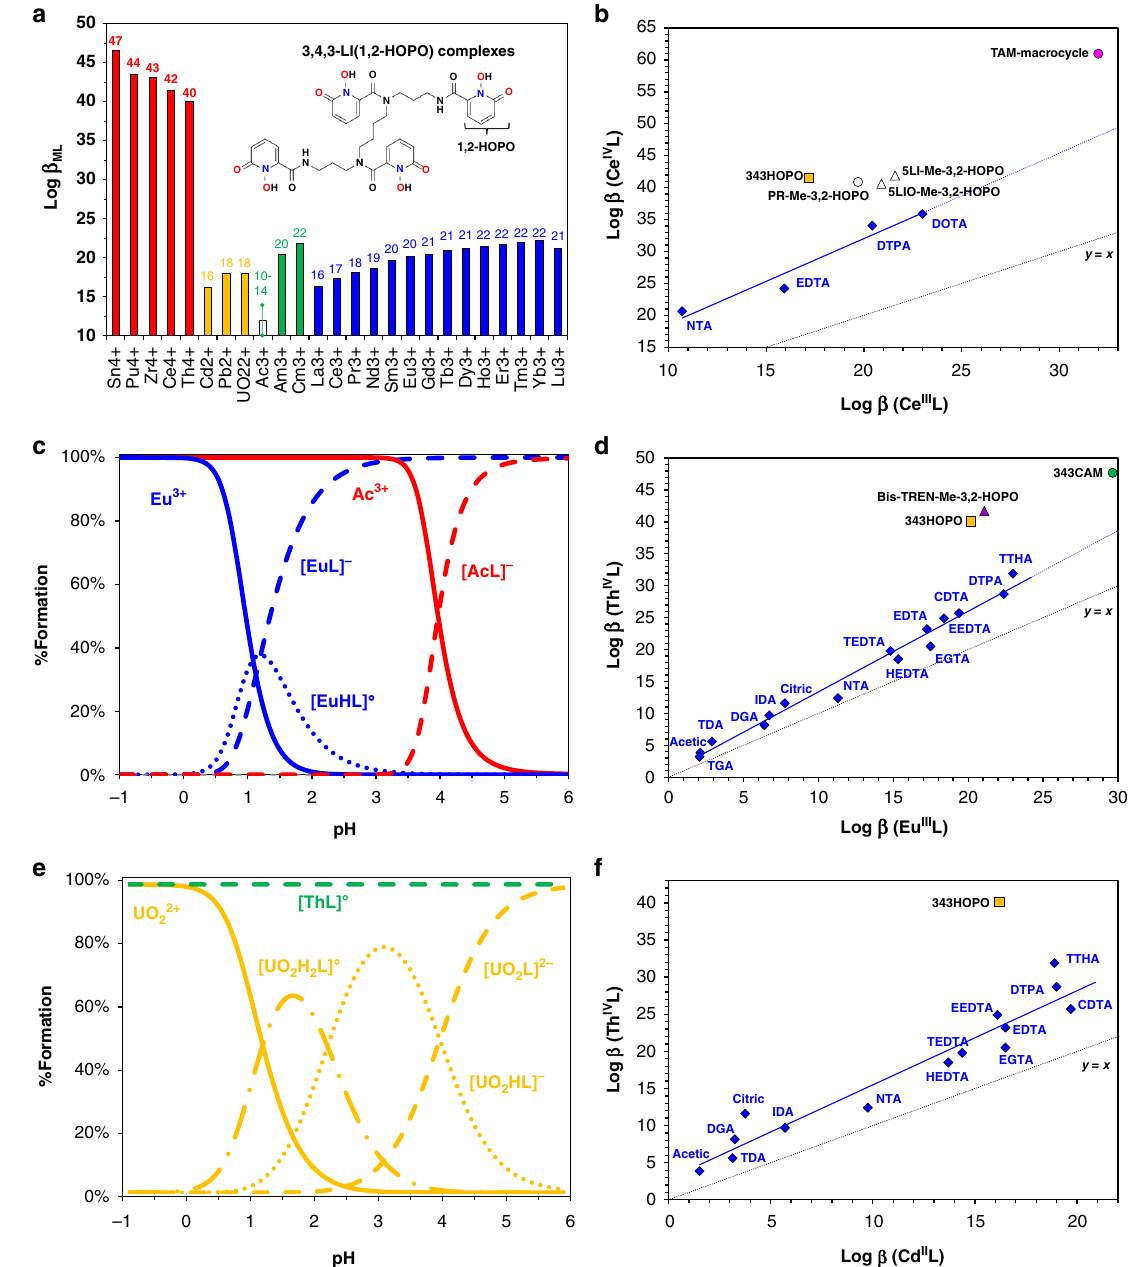
Fig. 1 Relative thermodynamic stabilities of metal-ligand complexes discussed in this work. a Stability constants (log β ML ) 24,25,46,48 – 50 of 343HOPO complexes with tetravalent cations (red), divalent ions (yellow), trivalent actinides (green), and trivalent lanthanides (blue). The value plotted for Ac 3 + is an estimate based on its ionic radius. Selectivity comparisons for Ce 4 + /Ce 3 + ( b ), Th 4 + /Eu 3 + ( d ), and Th 4 + /Cd 2 + ( f ), with HOPO and CAM ligands and classical chelators used in separations. For tetradentate ligands 5-LIO-Me-3,2-HOPO and 5-LI-Me-3,2-HOPO, the β ML2 value is used. For bidentate PR-Me- 3,2-HOPO, the β ML4 value is used. The line y = x corresponds to no selectivity. Additional selectivity comparisons are given in Supplementary Fig. 2. Full ligand names and structures are given in Supplementary Table 1. Metal speciation diagrams for 343HOPO solutions containing Ac 3 + or Eu 3 + ( c ) and UO 2 2 + or Th 4 + ( e ). [Chelator]/[Metal] = 1 mol/mol. L = Ligand. Solid lines: free metal. Dotted lines: 343HOPO